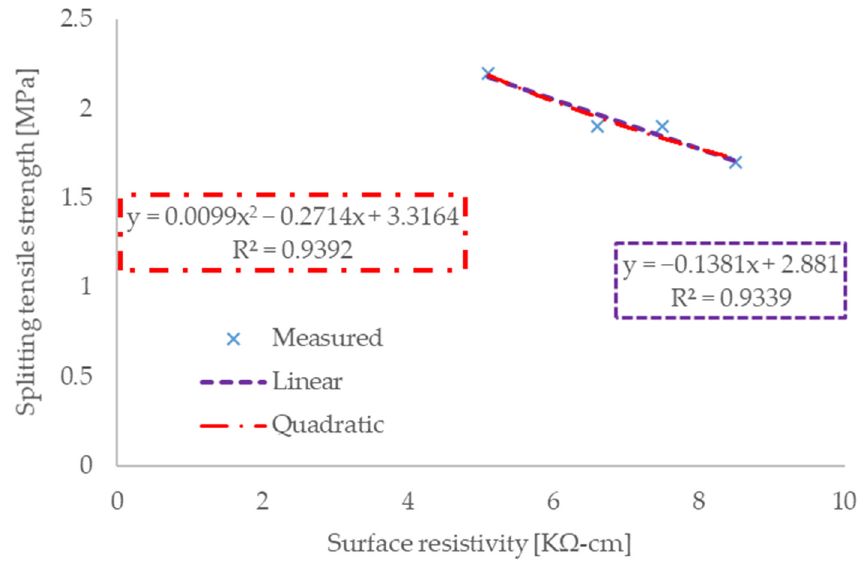
Figure 9. The relationship between surface resistivity and splitting tensile strength.